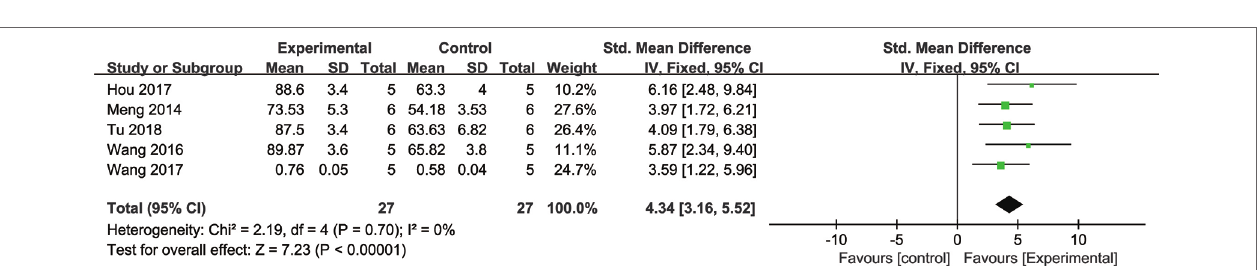
FIGURe 7 | The forest plot: effects of notoginsenoside R1 for reducing neurologic deficit score compared with the control group (n = 18 per group).